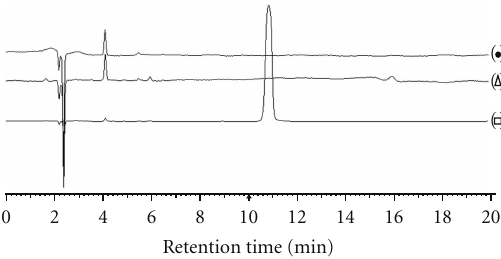
Figure 2: Chromatograms of solvent ( • ) placebo ( (cid:2) ) and standard solution of CB13 ( (cid:3)